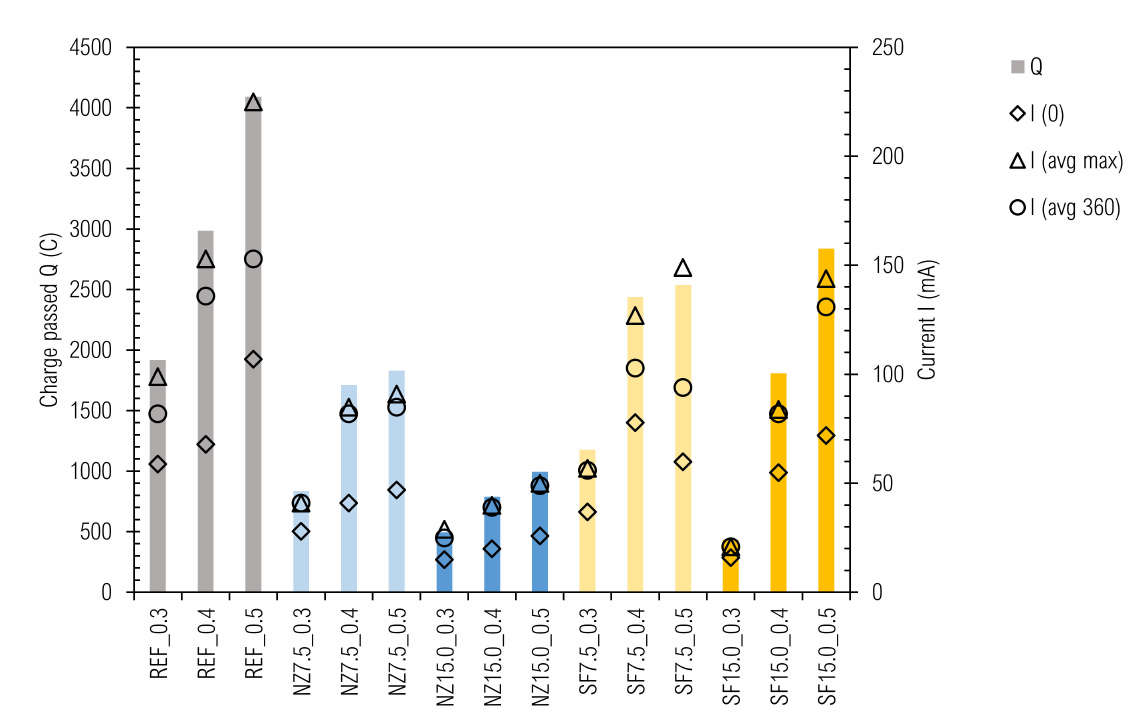
Figure 13. Chlorides penetration test